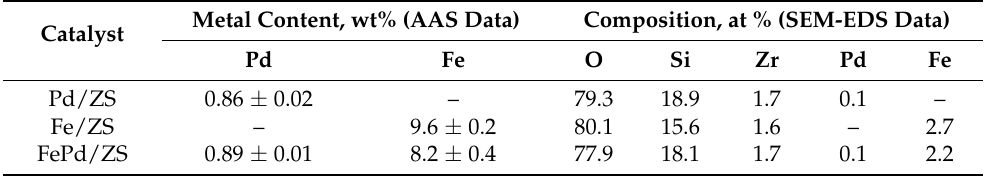
Table 2. Metal content and surface composition of the unreduced catalysts.